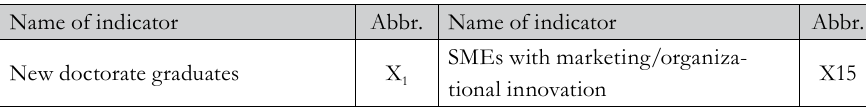
Tab. 1 – Indicators and Abbreviations. Source: own processing according to the European In- novation